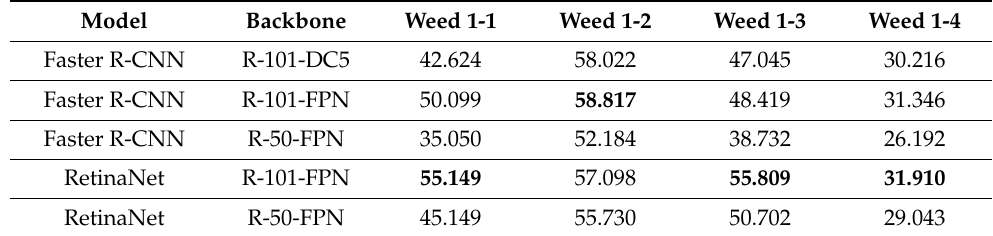
Table 8. Detecting weed growth stages using Faster R-CNN and RetinaNet (Average